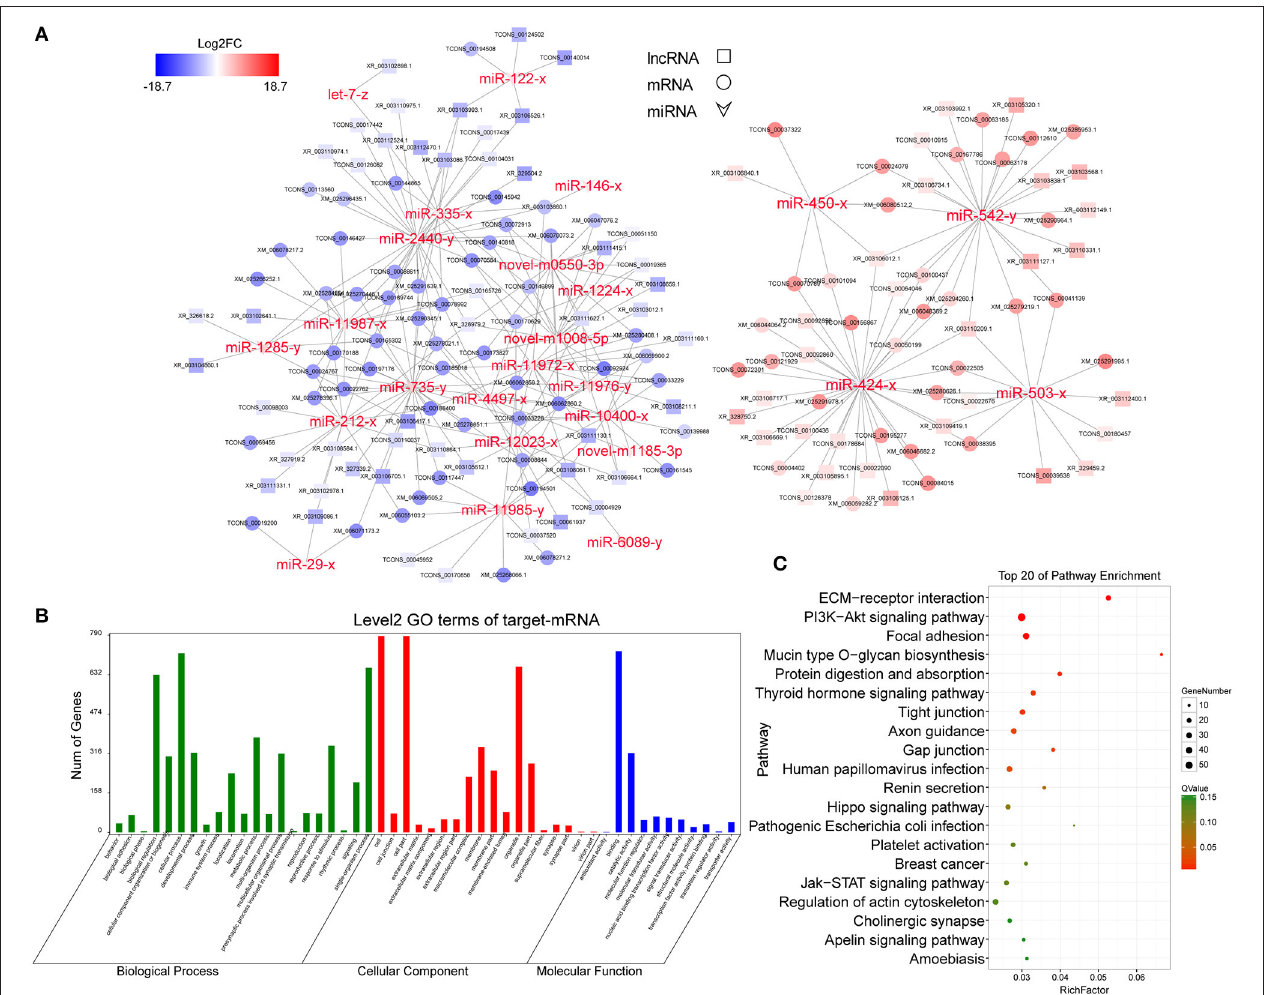
FIGURE 5 | CeRNA regulatory network and functional analysis. (A) CeRNA network built with the top 30 DEmiRNAs. Red and blue represent the upregulated and downregulated levels, respectively. (B) Level 2 GO enrichment of target mRNAs. (C) Top 20 KEGG pathways of target